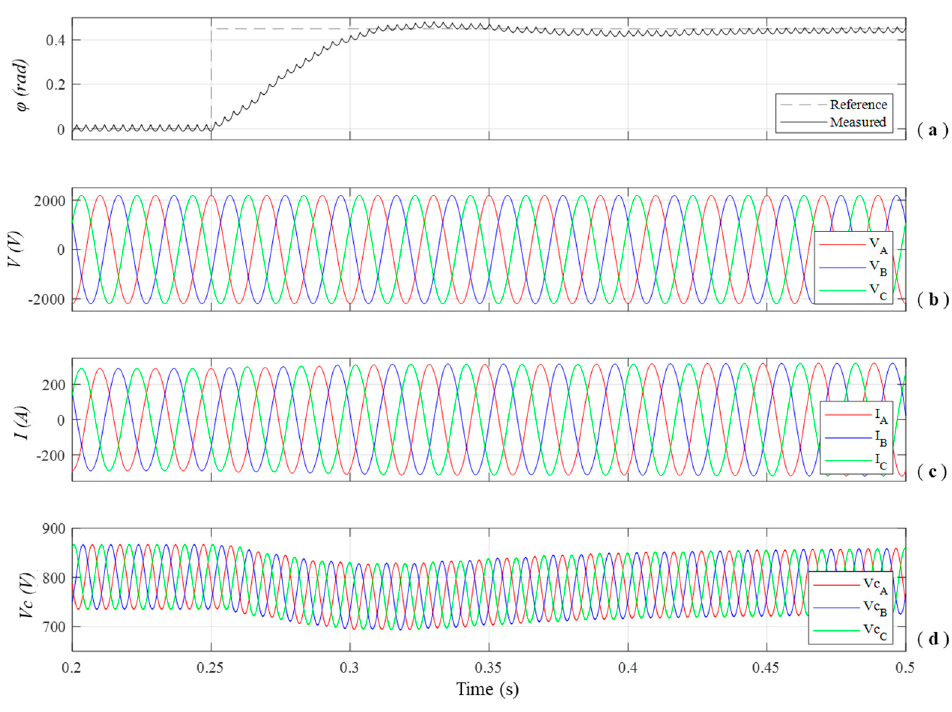
Figure 8. ( a ) Angle tracking, ( b ) grid phase-to-neutral voltages, ( c ) injected currents and ( d ) capacitor voltage of one cell of each phase in the first scenario.